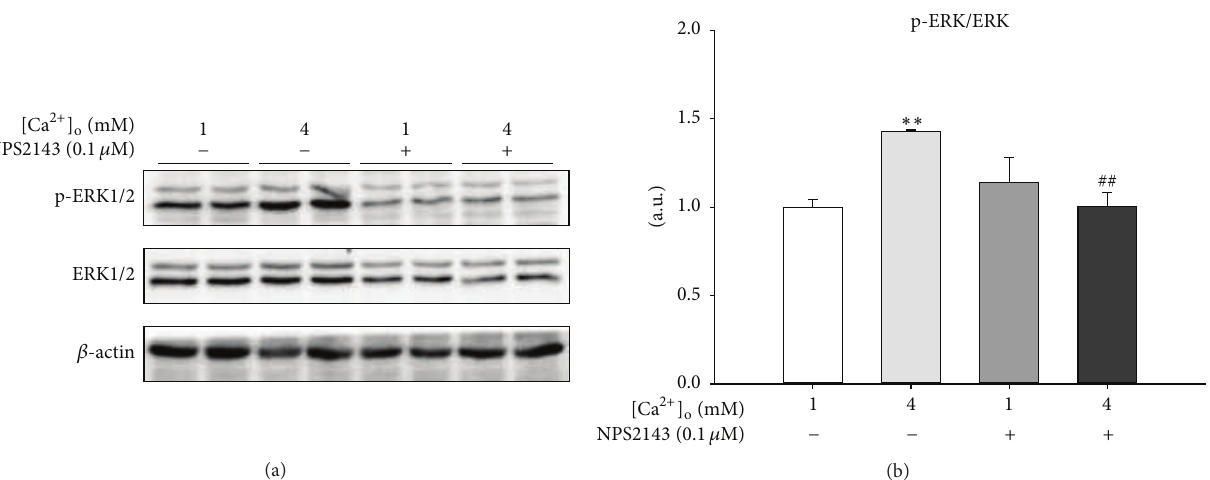
Figure 4: [ Ca 2+ ] o activated ERK1/2 during the proliferation of pBMSCs. (a) Western blot analysis of phosphor-ERK (p-ERK) and ERK in pBMSCs after 5-day culture. 𝛽 -actin was used as loading control. (b) Mean ± SEM of immunoblotting bands of p-ERK/ERK; the intensities of the bands were expressed as the arbitrary units ( 𝑛 = 4 ). ∗∗ 𝑃 < 0.01 versus 1mM [ Ca 2+ ] o group (control); ## 𝑃 < 0.01 versus 4mM [ Ca 2+ ] o